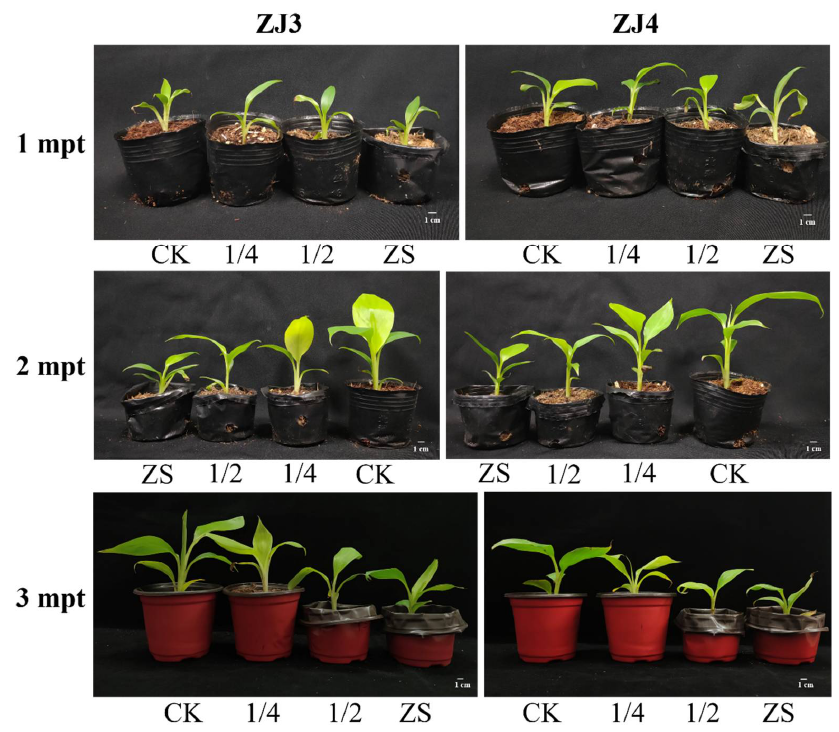
Figure 6. Effects of bamboo fungus on the growth of ‘Zhongjiao No.3’ (ZJ3) and ‘Zhongjiao No.4’ (ZJ4) banana seedlings. CK, 1/4, 1/2, and ZS represents typical banana seedlings grown in nutrient soil containing no, 1/4, 1/2, and complete bamboo fungus culture substrates, respectively. Table 3. Effects of bamboo fungus on the root growth parameters and biomass of ‘Zhongjiao No.3 ’ (ZJ3) and ‘Zhongjiao No.4 ’ (ZJ4) banana seedlings. CK: seedlings grown in nutrient soil; 1/4: seed- lings grown in nutrient soil containing 1/4 bamboo fungus culture substrates; 1/2: seedlings grown in nutrient soil containing 1/2 bamboo fungus culture substrates; ZS: seedlings grown in bamboo fungus culture substrates. The different letters within the same column represent significant differ- ence among samples at 0.05 level.